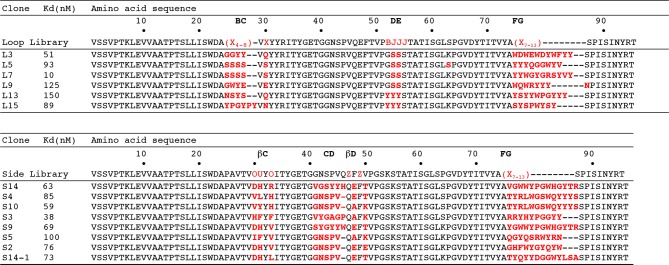
Sequences of monobodies selected against human PRDM14 and their KD values to hPRDM14 measured in yeast display format.Two types of libraries were used, loop and side library. In the library designs, 'X' denotes a mixture of 30% Tyr, 15% Ser, 10% Gly, 5% Phe, 5% Trp, and 2.5% each of all the other amino acids except for Cys, 'B', a mixture of Gly, Ser and Tyr, 'J', a mixture of Ser and Tyr, 'O', a mixture of Asn, Asp, His, Ile, Leu, Phe, Tyr, and Val, 'U', a mixture of His, Leu, Phe and Tyr, 'Z', a mixture of Ala, Glu, Lys and Thr (Koide et al. 2012). A hypen indicates a deletion.